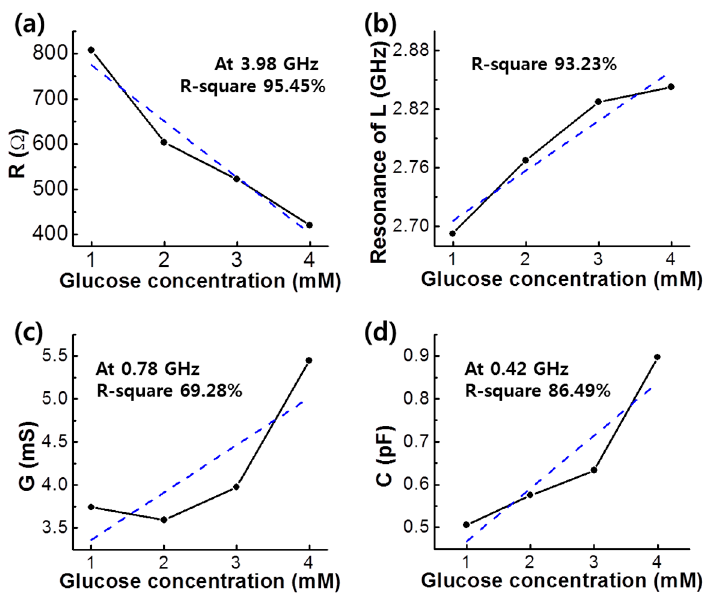
Figure 6. Linearity of ( a ) resistance, R ; ( b ) resonance feature of inductance, L ; ( c ) shunt conductance, G ; and ( d ) shunt capacitance, C , of PBA/RGO device according to adding glucose with different concentrations from 1 to 4 mM.